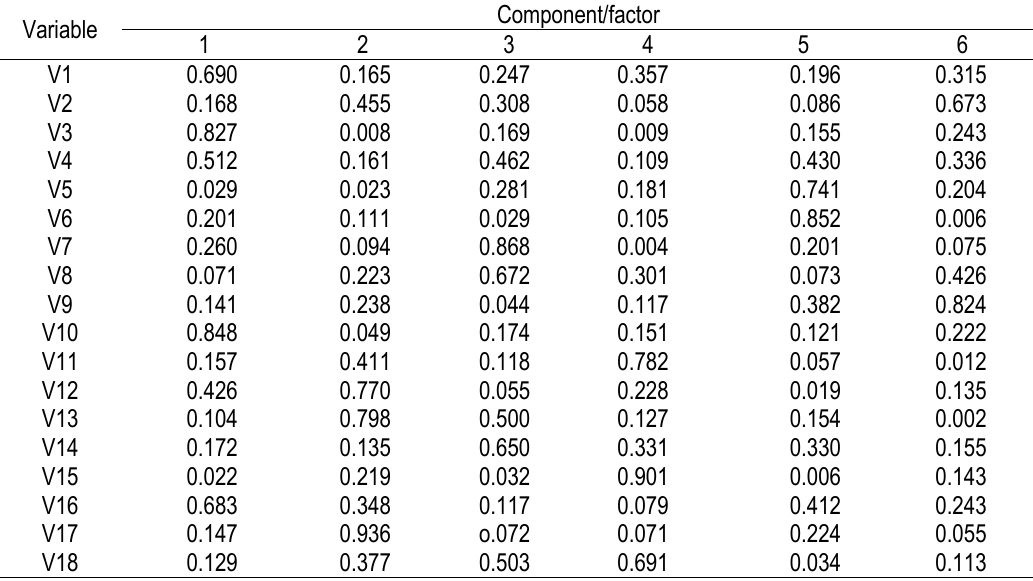
Table 10. Rotated Matrix Showing Factor Loadings of Different Variables on Six Factors